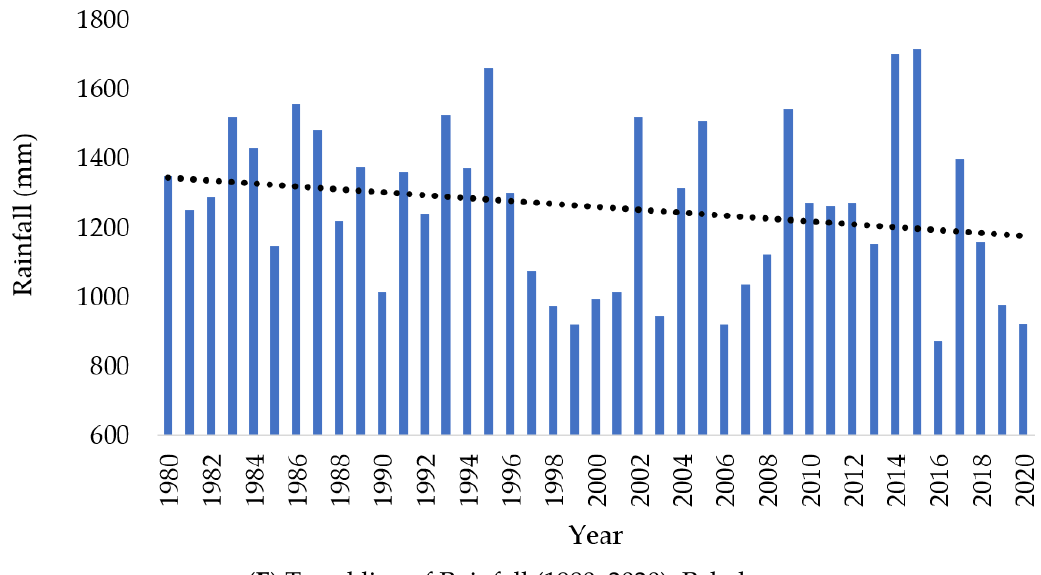
Figure 4. Descriptive statistics of weather parameters viz., Maximum and Minimum temperature and rainfall of location Pahalgam.